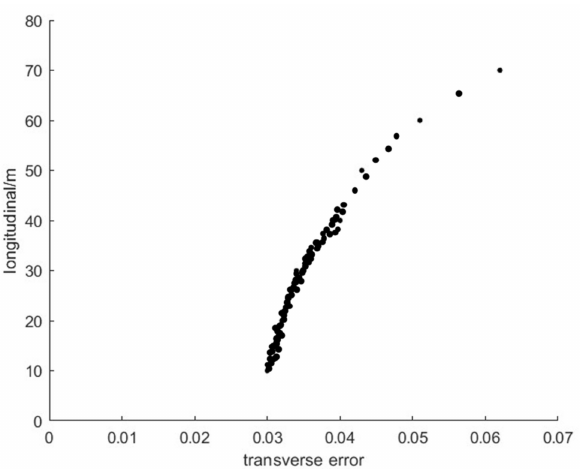
Figure 18. Relationship between longitudinal distance and transverse